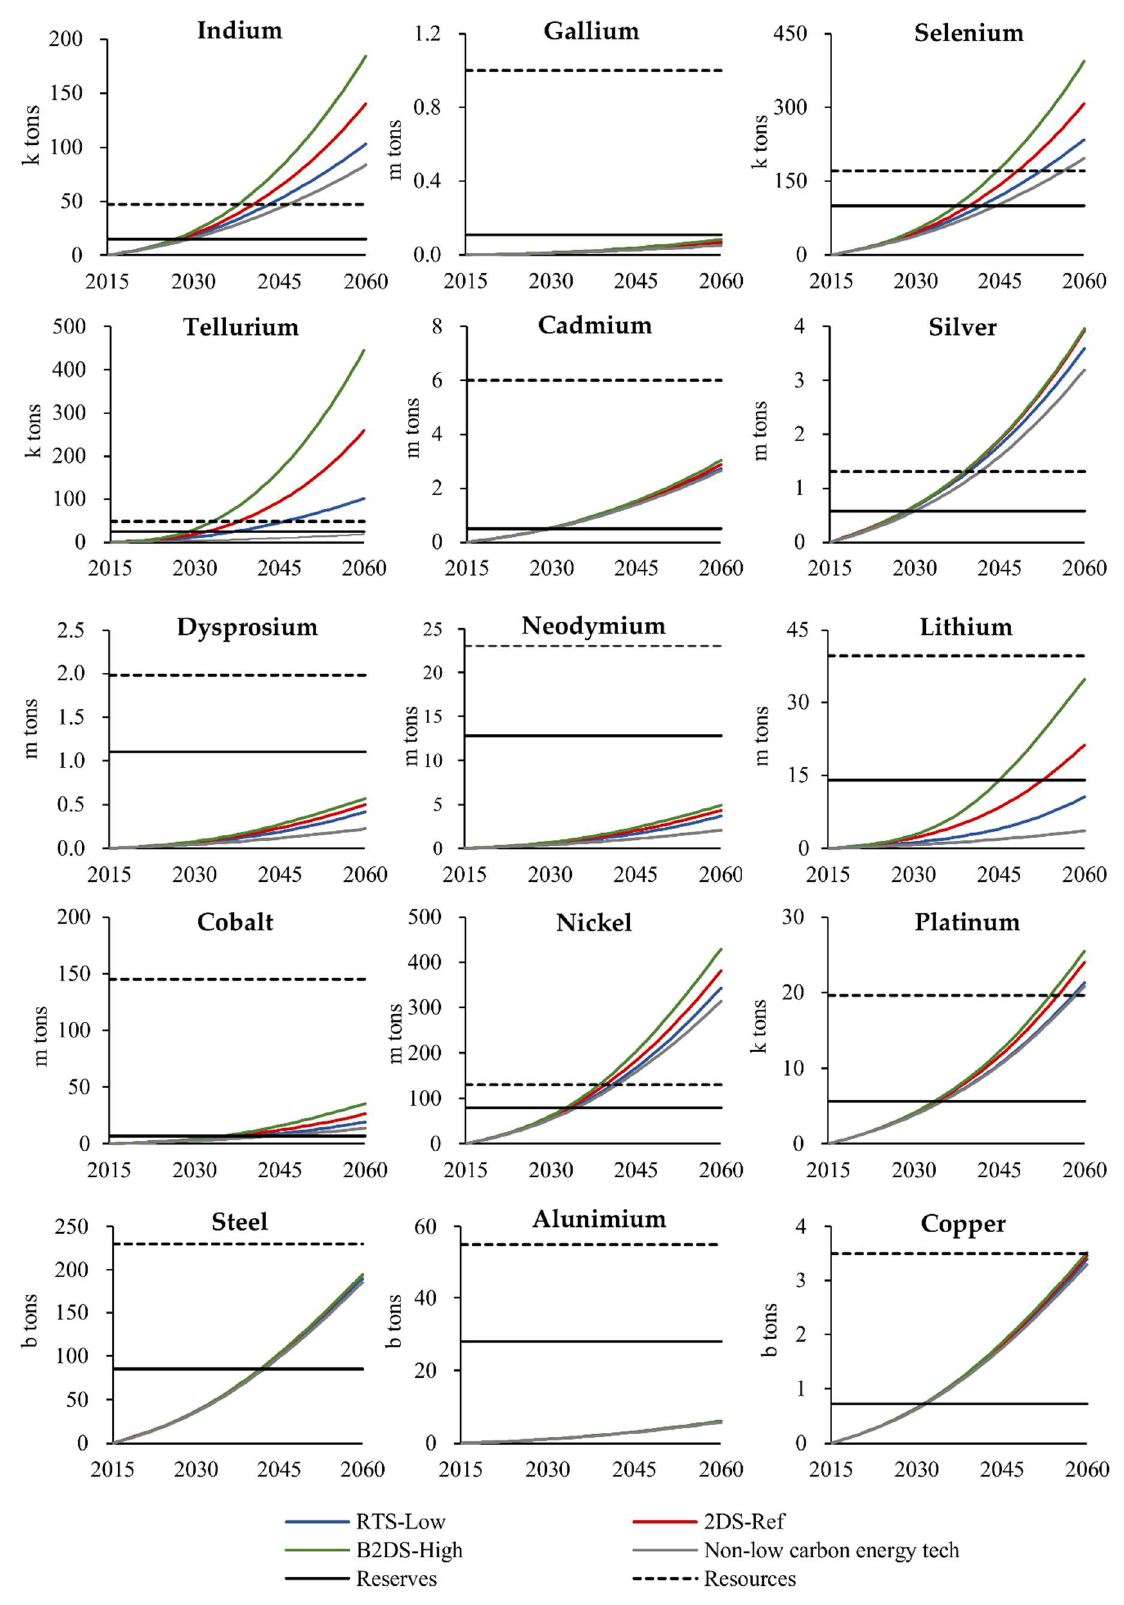
Figure 11. Estimated cumulative demand for all uses from 2016 to 2060.